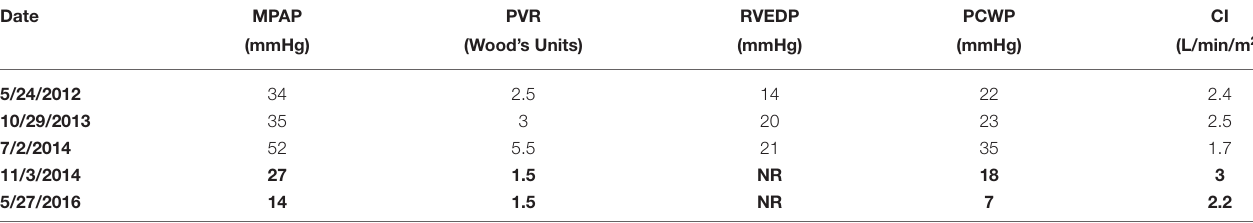
TABLE 1A | Cardiac catheterization data over the 3 years before and 2 years after VAD placement.